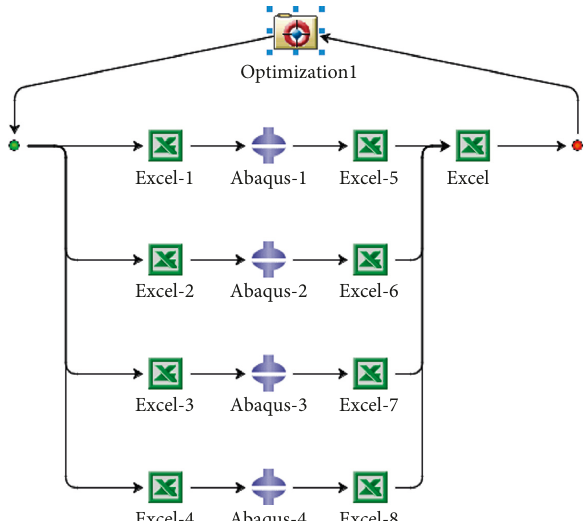
Figure 3: Flow-process diagram of Isight optimization of H